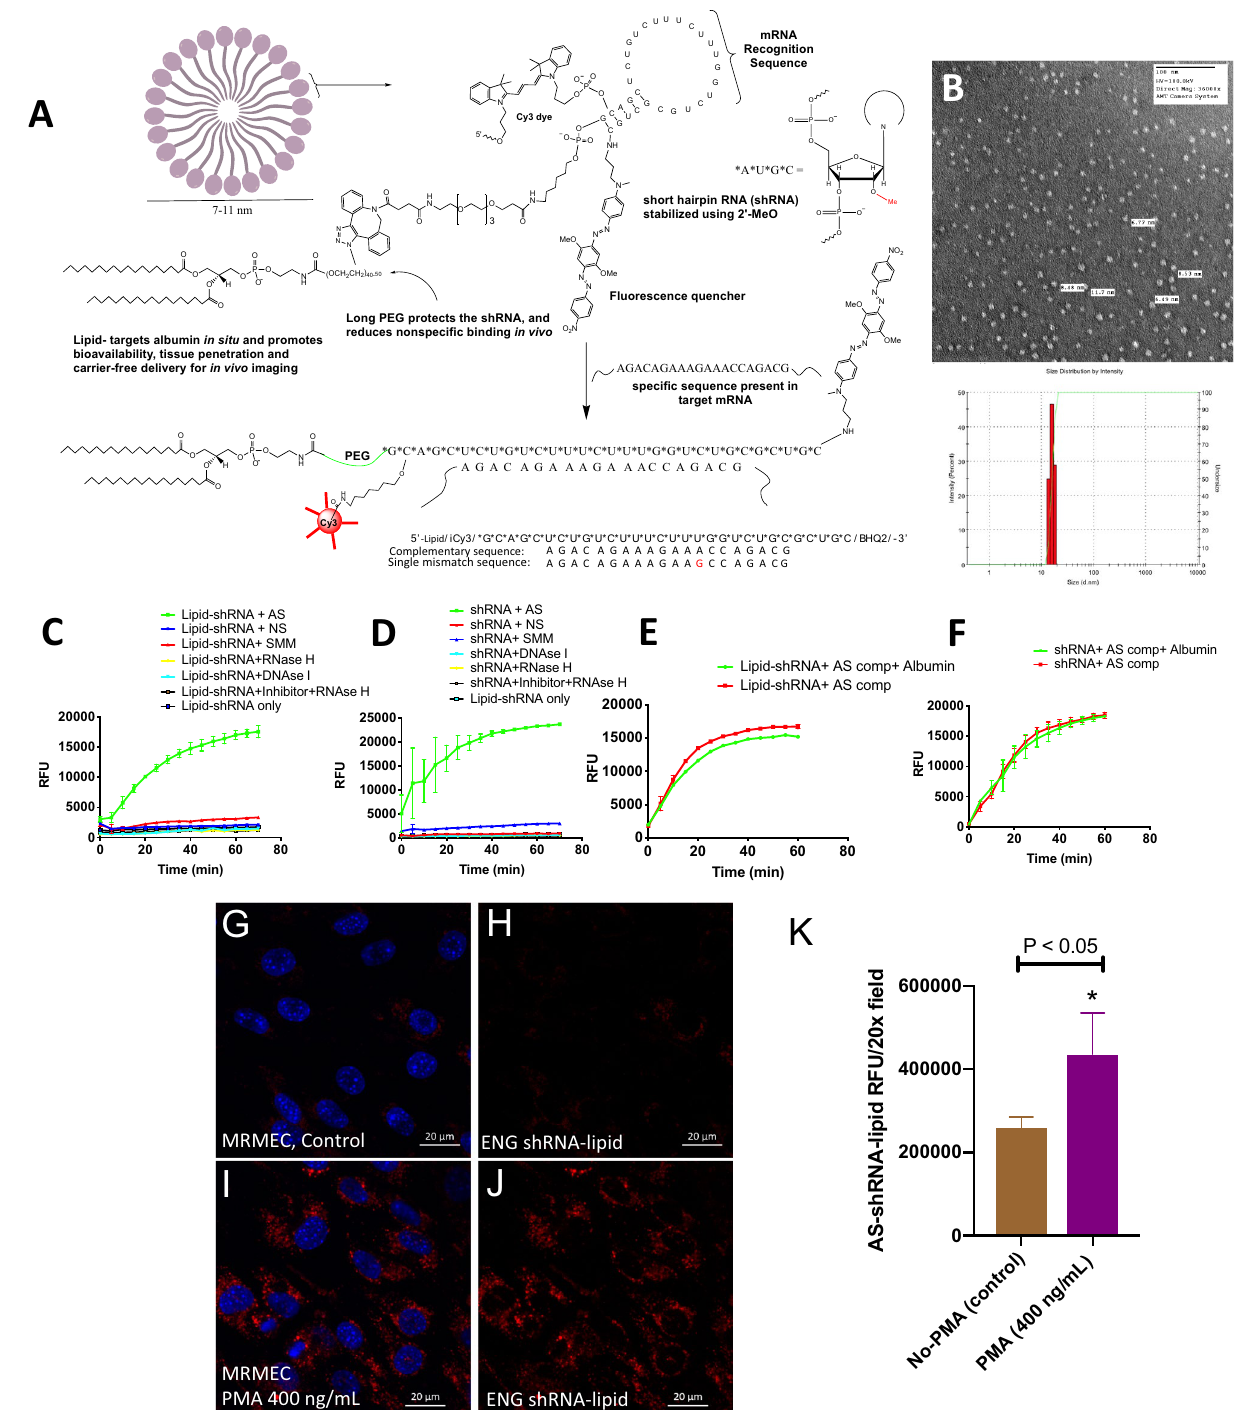
Figure 1. Design and characterization of AS-Eng shRNA–lipid. ( A ) Schematic drawing and hybridization motif of shRNA–lipid conjugates showing the design incorporating anti-sense sequence complementary to the endoglin mRNA. ( B ) Transmission electron microscopy (TEM) images and dynamic light scattering (DLS) measurement of the synthesized shRNA–lipid conjugates. ( C , D ) Both shRNA and shRNA–lipid conjugates are highly specific for their complementary sequences and do not hybridize with a single-mismatched (SMM) sequence that is otherwise complimentary. ( E , F ) Lipid- shRNA hybridization reactions to an exogenous complementary sequence in the presence and absence of albumin. The resulting increased fluorescence observed both conditions indicate albumin does not effect hybridization to the target sequence. ( G – K ) Localization of AS-Eng AS-shRNA–lipid in mouse retinal microvascular endothelial cells (MRMECs) using fluorescence microscopy. ENG mRNA is induced in MRMECs by treating the cells with 400 ng/mL phorbol 12-myrestyle 13-acetate (PMA) for 24 h. DAPI is used to counterstain the nucleus (blue). Fluorescence intensities were measured computationally using ImageJ software (n = 6). Statistical significance *P < 0.05. AS anti-sense complementary oligonucleotide, NS non-sense oligonucleotide, SMM single-mismatched